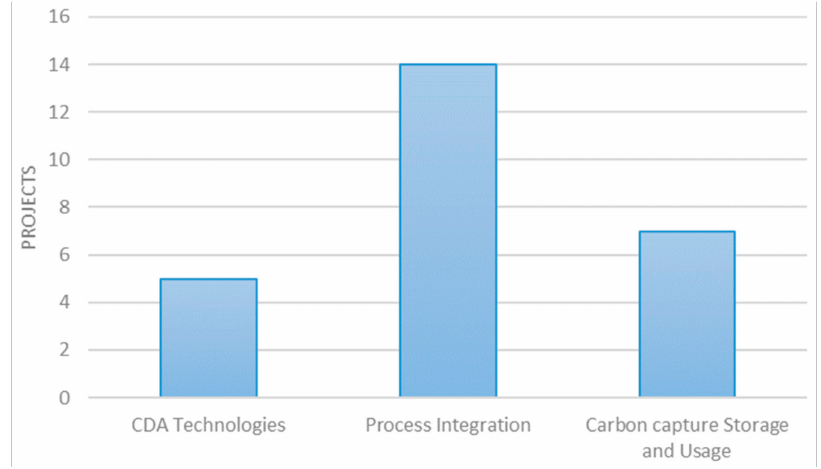
Figure 3. Number of projects related to low-carbon